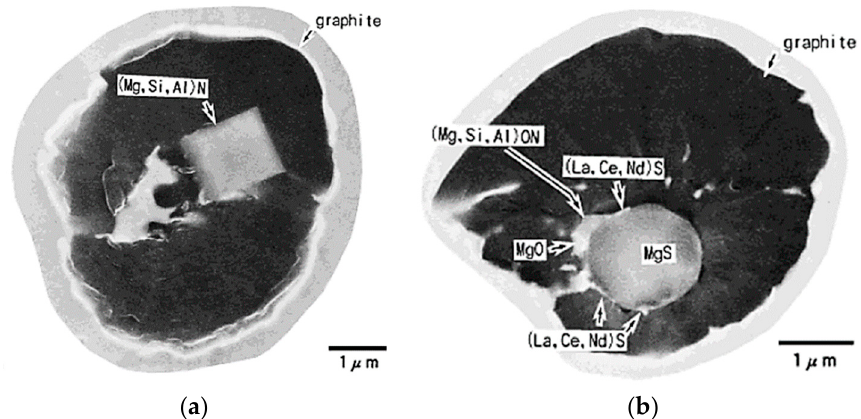
Figure 20. SEM micrographs of graphite spheroids in irons with different sulfur in the base metal: ( a ) (Mg,Si,Al)N in the 0.0022%S base iron; ( b ) MgS in the 0.013%S base iron; reproduced from [102] with permission from Materials Trans. JIM.